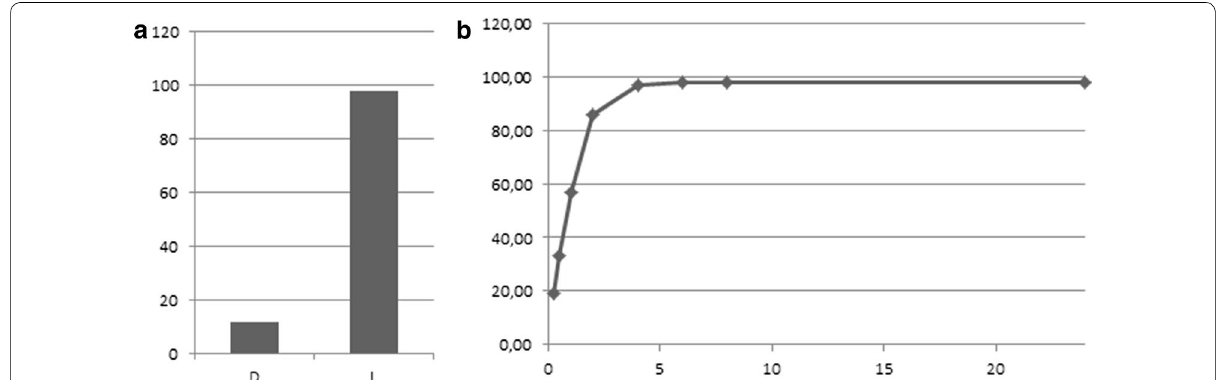
Fig. 2 a d ‑ and l ‑tryptophan conversions by Xszen FHal with NaCl over 24 h. b Time course of l ‑tryptophan conversion by Xszen FHal with NaCl over 24